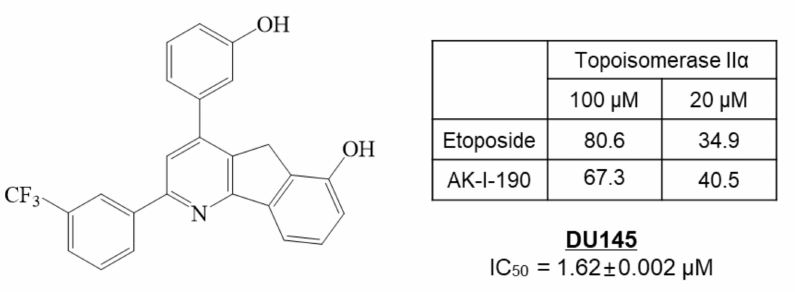
Figure 1. The structure and topoisomerase II inhibitory and anti-proliferative activities of AK- I-190 (2-(3-trifluorophenyl)-4-(3-hydroxyphenyl)-5 H -indeno[1,2- b ]pyridin-6-ol) in DU145 prostate cancer